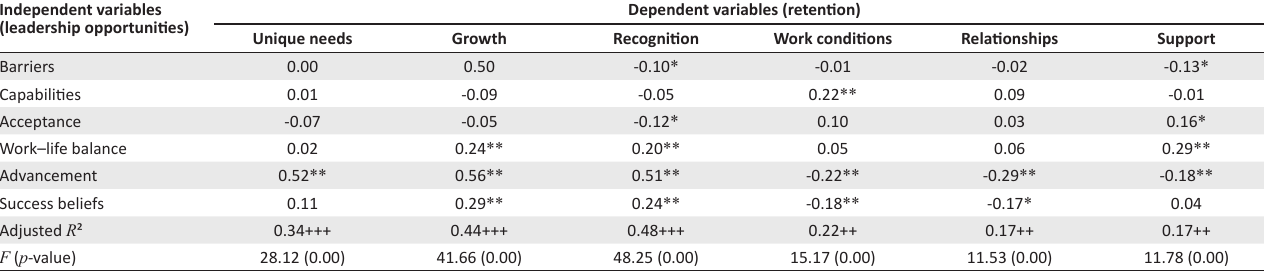
TABLE 3: Regression results for leadership contingencies and retention. Independent variables (leadership